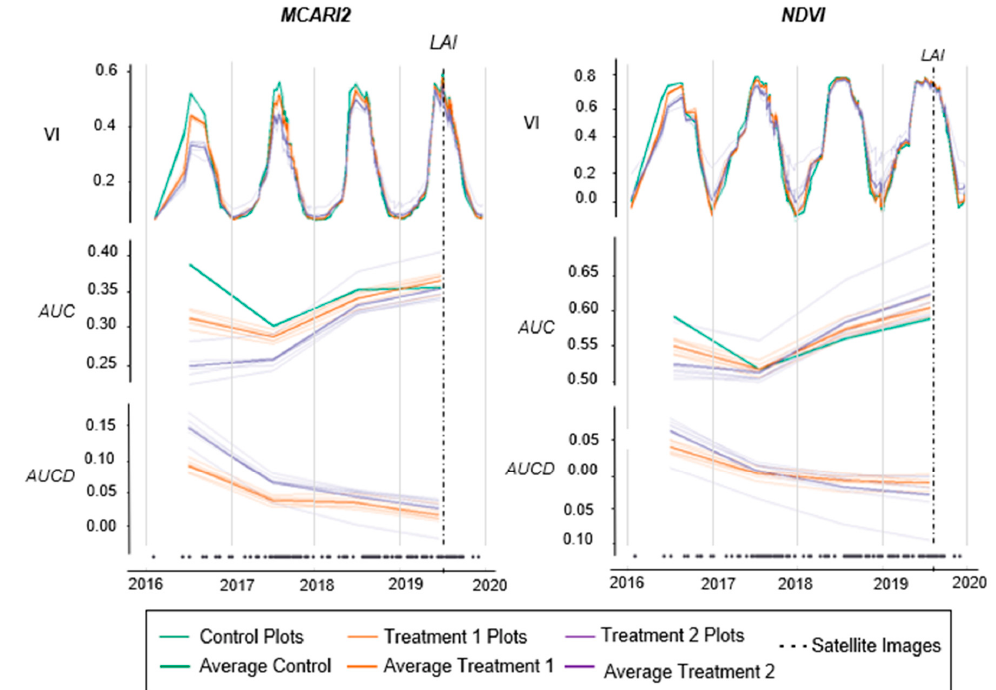
Figure 7. Evolution of the values for MCARI2 and NDVI with all the valid S2 images available from 2016 to 2019 Trial 1. Areas under the annual VI curves ( AUC ) and differences in AUC between control and treatment plots ( AUCD ) for the same time series. LAI refers to when fieldwork was carried out.